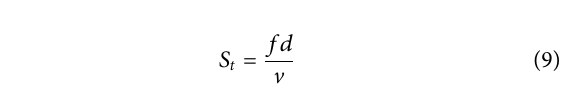
Frontiers in Materials |